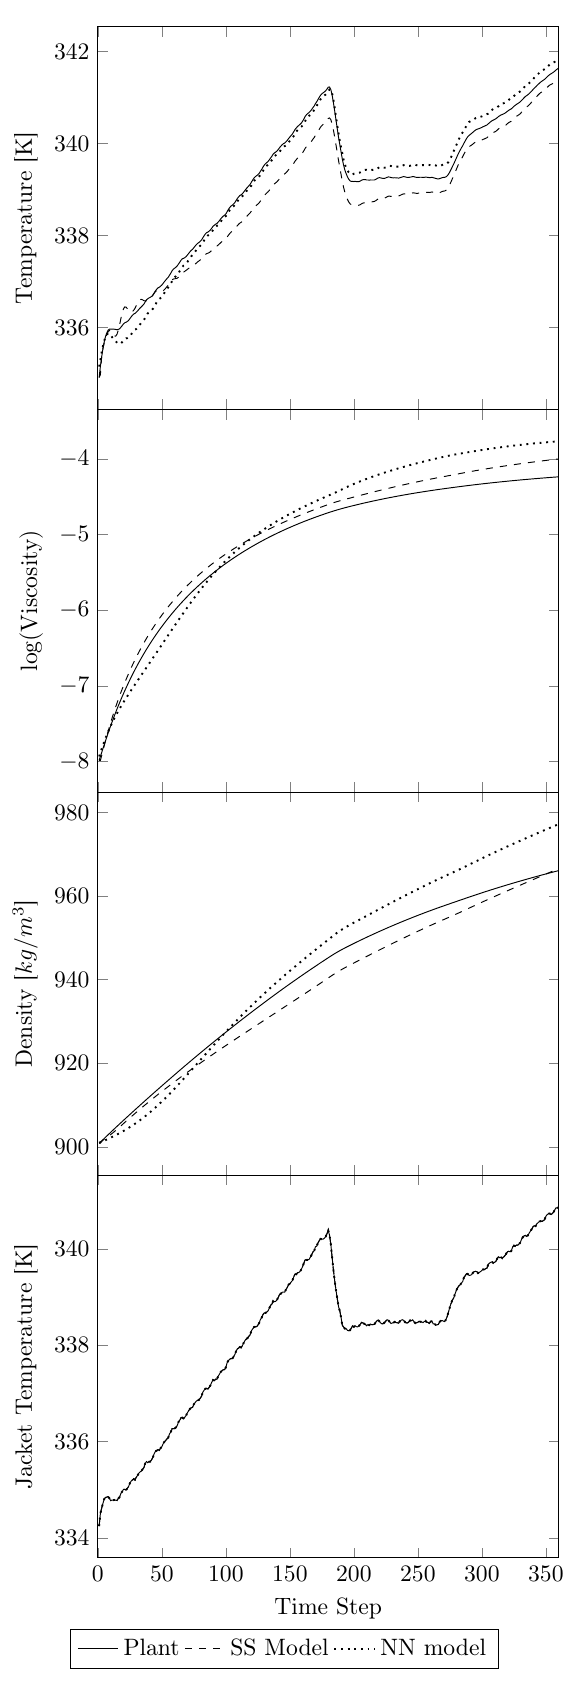
Figure 3. Validation of state-space models and NARX networks in the absence of measurement